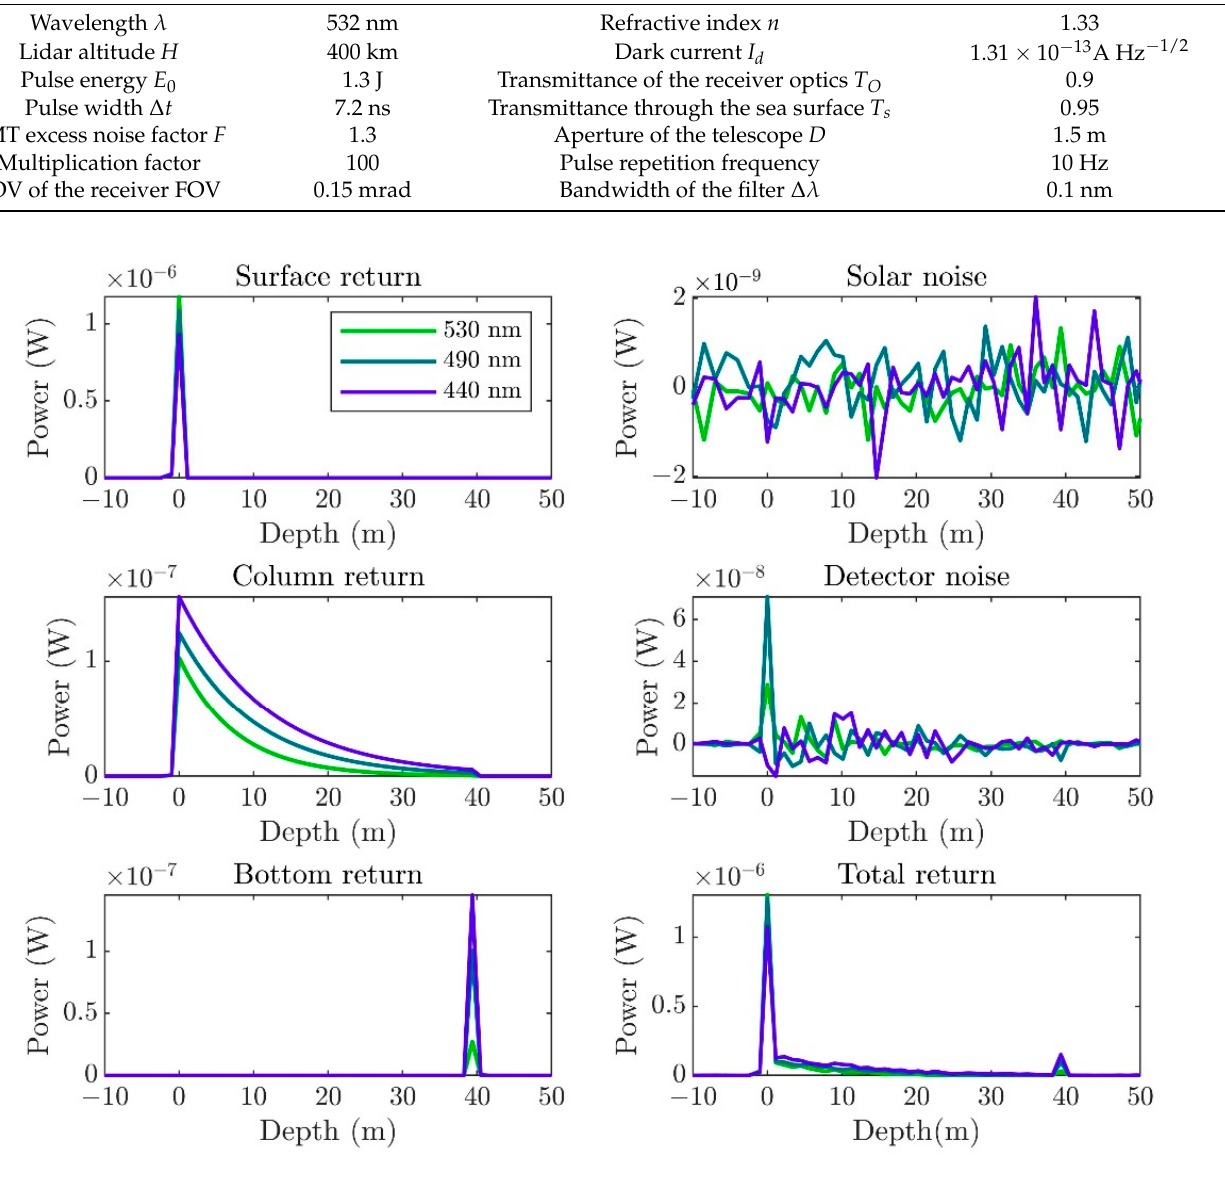
Figure 3. Simulated waveforms of each part (sea surface return, sea column return, sea bottom return, solar background noise, detector shot noise, and total return signal, respectively) in clear water with chlorophyll concentration of 0.1 mg/m 3 , a g ( λ 0 ) = 0.01 m − 1 and laser wavelength of 530 nm, 490 nm, and 440 nm with a 40-m sea bottom depth.